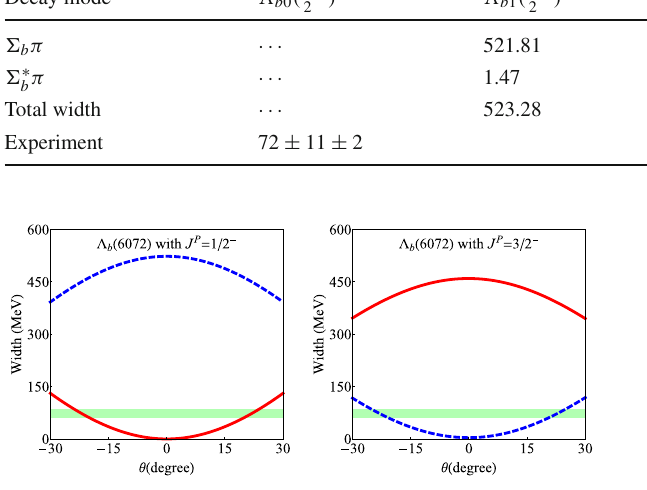
Table 4 Strong decays of the (cid:2) b ( 6072 ) as ˜ (cid:2) b ( 1 P ) states in MeV Decay mode